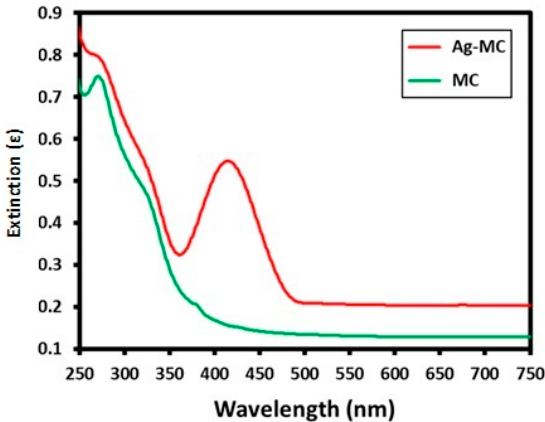
Figure 1. UV-Vis spectra of pure Myrtus communis L. plant extract (MC) and green synthesized silver nanoparticles using Myrtus communis L. extract (Ag-MC).